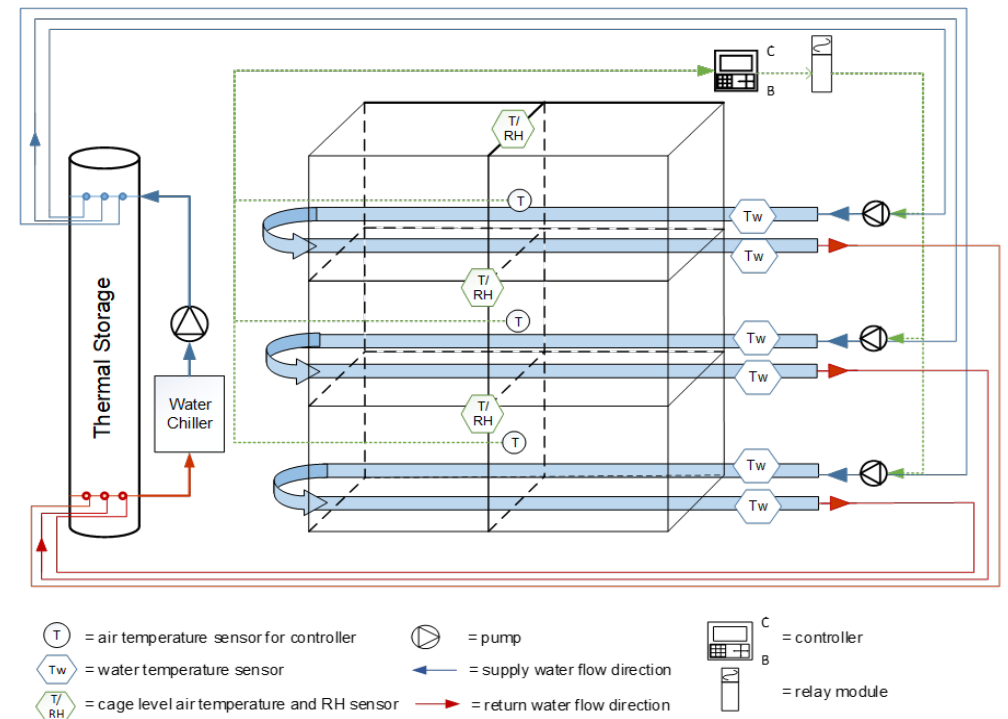
Figure 1. Schematic of the cooled perch system and instrumentation. Two systems were fabricated. Each system consisted of three loops (top, middle, and bottom) and each loop was individually operated by a pump that drew chilled water from a thermal storage manifold. The thermal storage was cooled by an independent loop consisting of a pump that continuously circulated water between the manifold and a water chiller (10 ◦ C). Each loop pump was individually thermostatically controlled based on the air temperature within the cage. Instrumentation included inlet and return line water temperatures, cage air temperatures, and relative humidity (RH) (Modified from [42,43]).